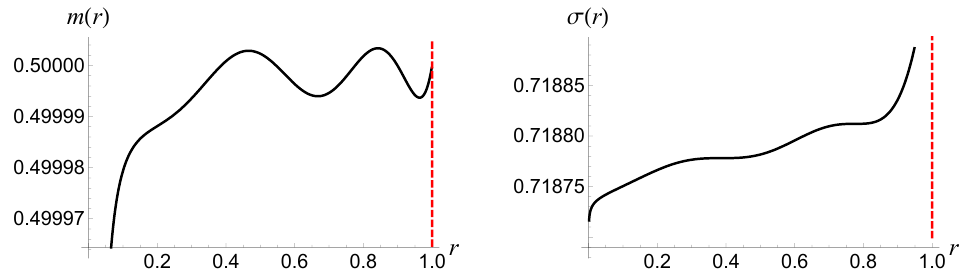
Figure 6 . The metric functions m and σ which reflect the oscillatory behavior of φ in the black hole